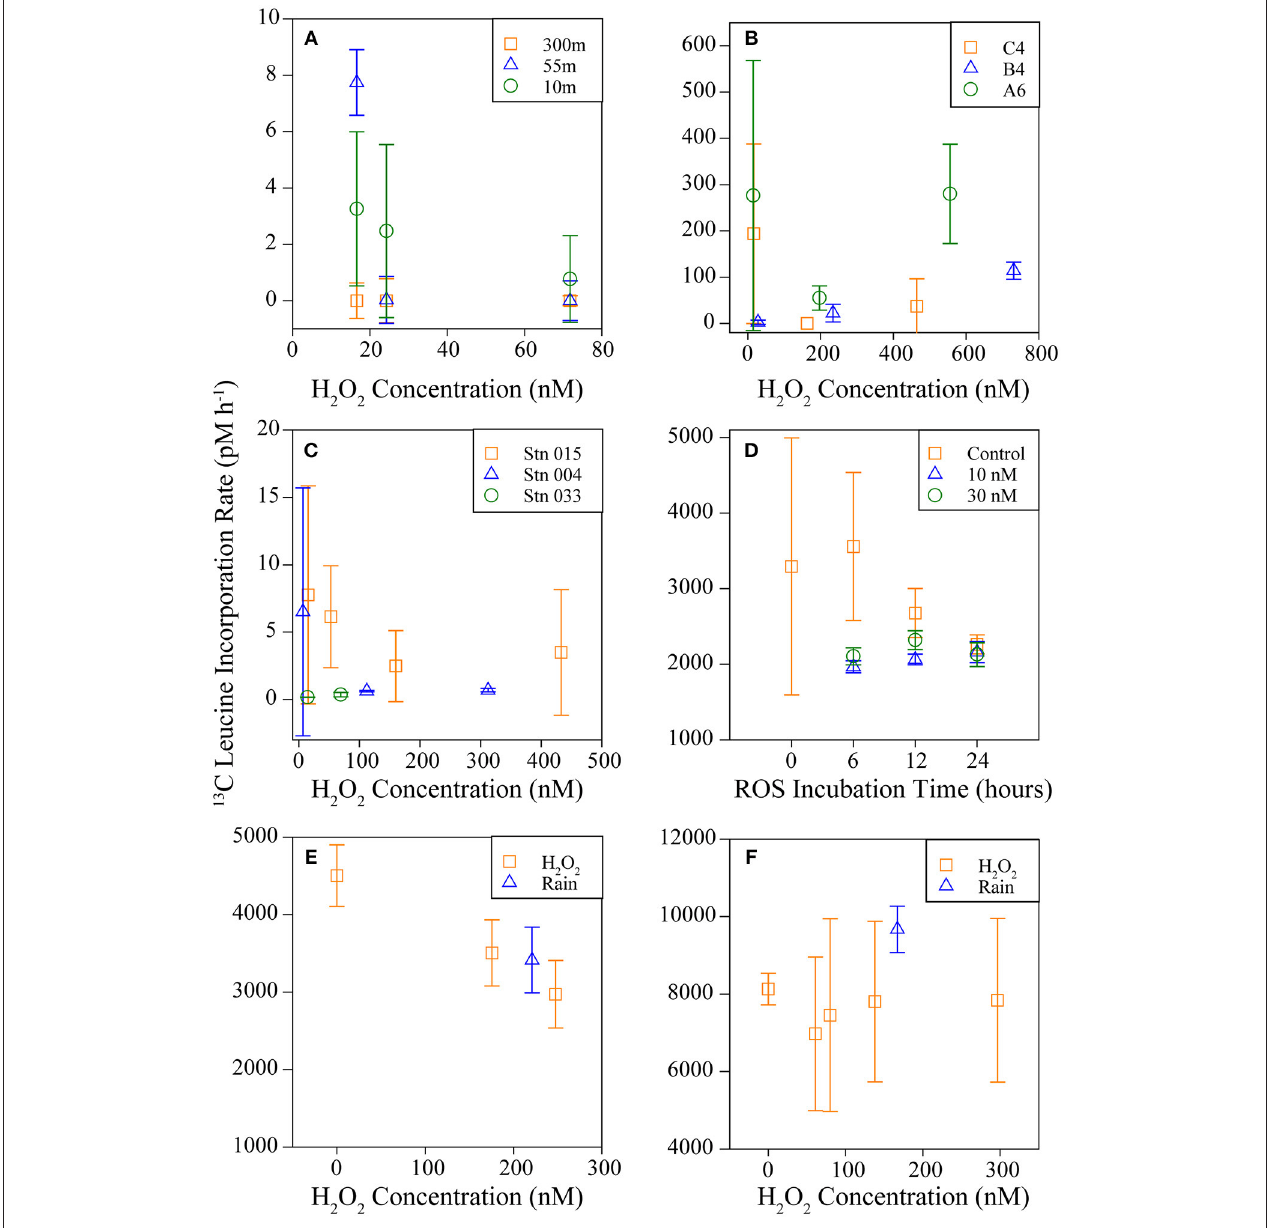
FIGURE 6 | Bacterial and archaeal incorporation of L-leucine measured in the Southern Ocean (A; symbols represent sample depth), the Gulf of Mexico, and the Gulf of Alaska (B,C , respectively; symbols represent station sampled), and Marsh Landing in 2011 (D ; symbols represent H 2 O 2 addition), 2012, and 2013 (E,F , respectively; symbols represent H 2 O 2 origin, either chemical H 2 O 2 or from rainwater). Incubations were performed using 3 H-labeled (A,D) or 13 C-labeled (B,C,E,F) L-leucine. Error bars represent standard deviation from the mean of replicate measurements [ n = 6 (A) , 3 (C,D) , 2 (B,E,F)